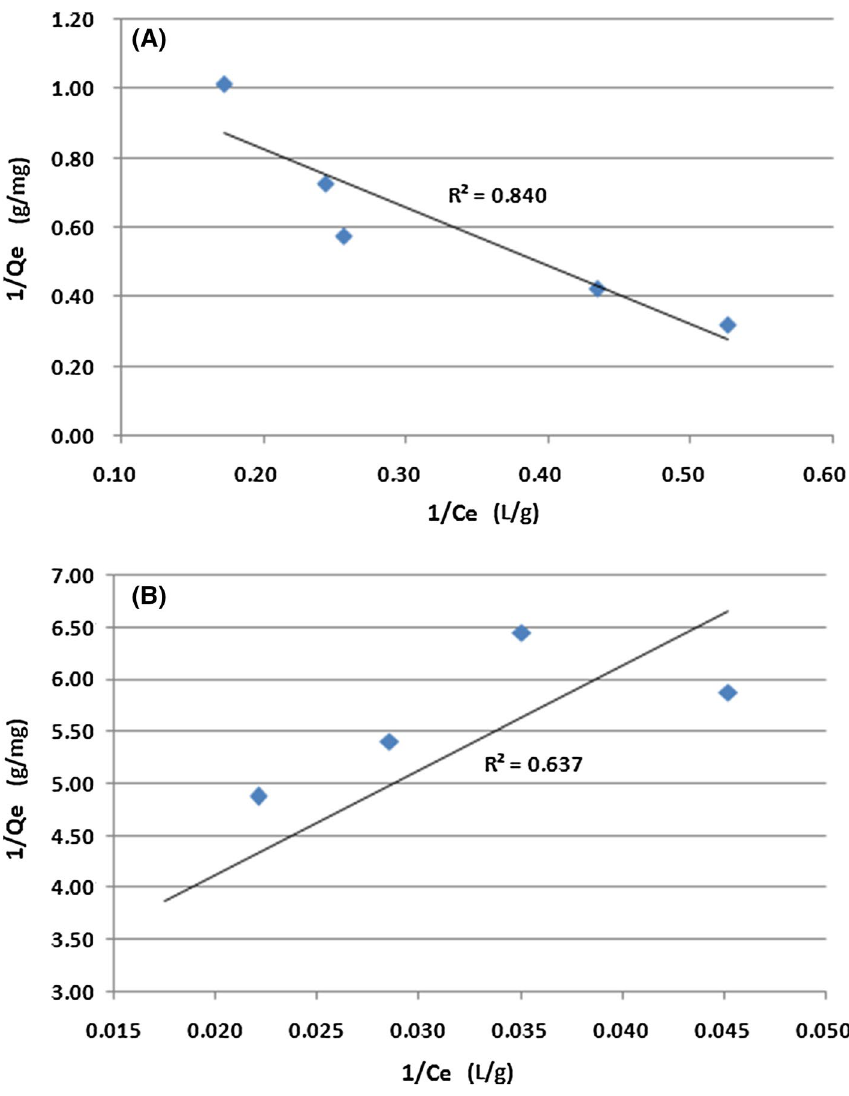
Fig. 4 Langmuir adsorption isotherm for La 3+ by pre-treated Bacillus subtilis cells. a NaOH pre-treated cells, b HCl pre- treated